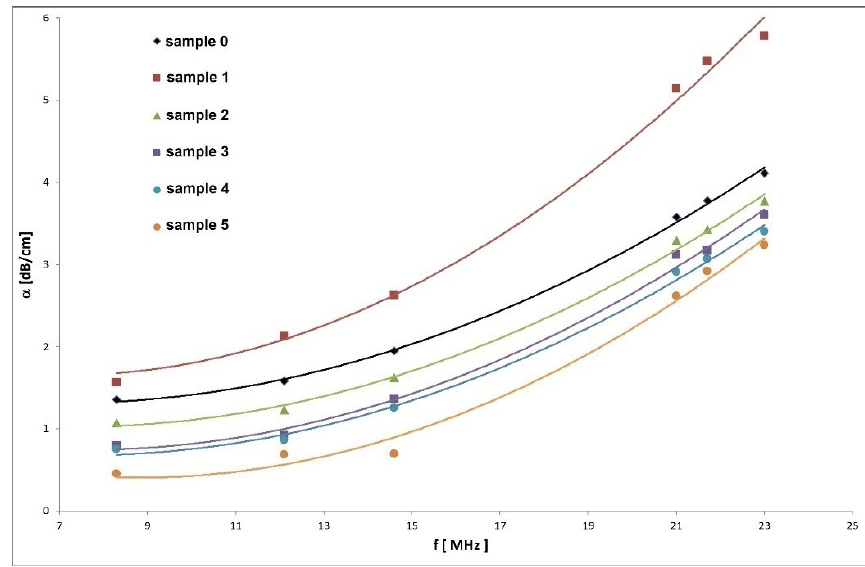
Figure 2. Frequency dependence of ultrasonic attenuation for the samples with different values of relative reduction, 0% ( 0 ), 10% ( 1 ), 20% ( 2 ), 30% ( 3 ), 40% (4) and 50% (50) measured in frequency range 8.2–23.1 MHz.